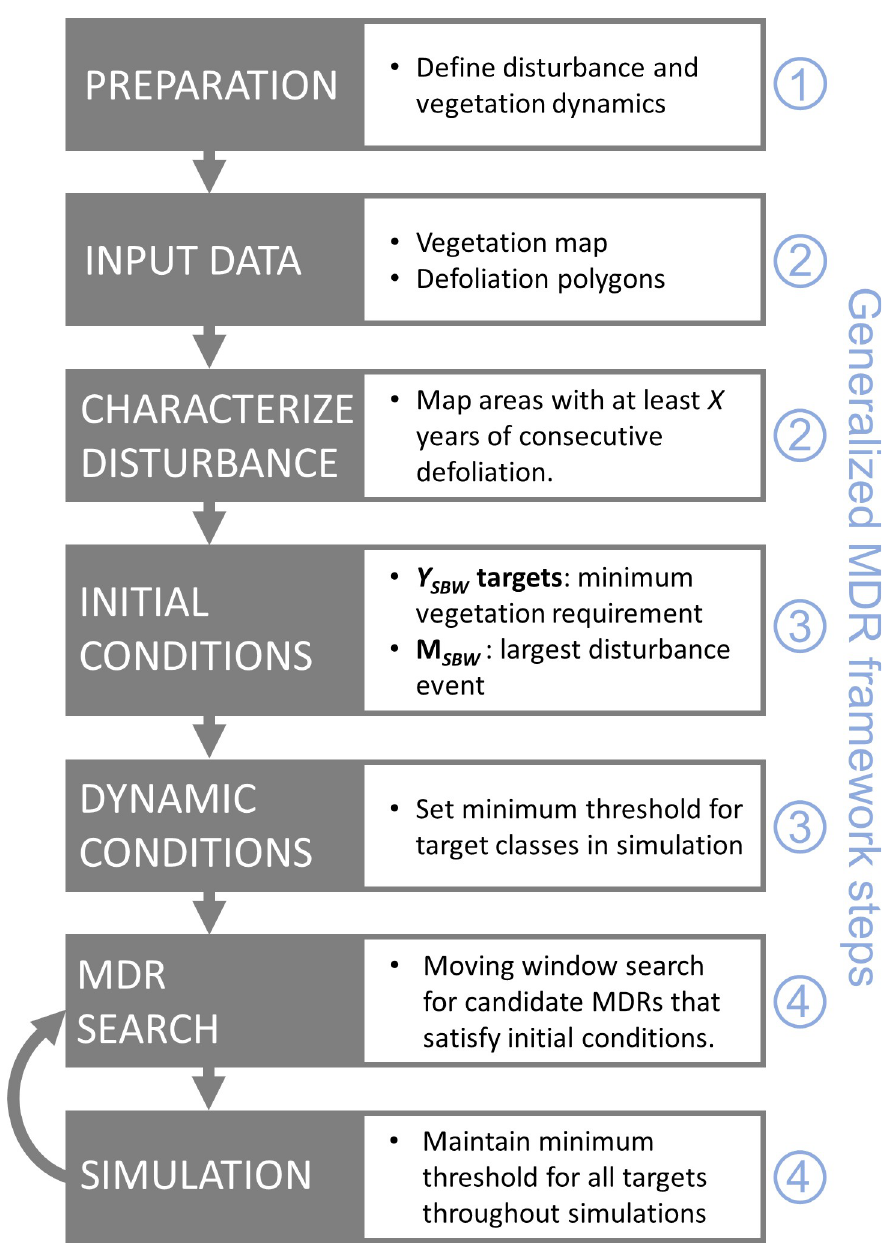
Fig 2. Generalized work flow for calculating spruce budworm MDR values. Analysis steps are shown in boxes, and the associated steps from the generalized MDR framework for defoliating insects are shown in blue (1: vegetation dynamics, 2: data, 3: initial and dynamic conditions, 4: iterative MDR search). Details can be found in the generalized MDR framework steps 1–4 and Eqs 1 and